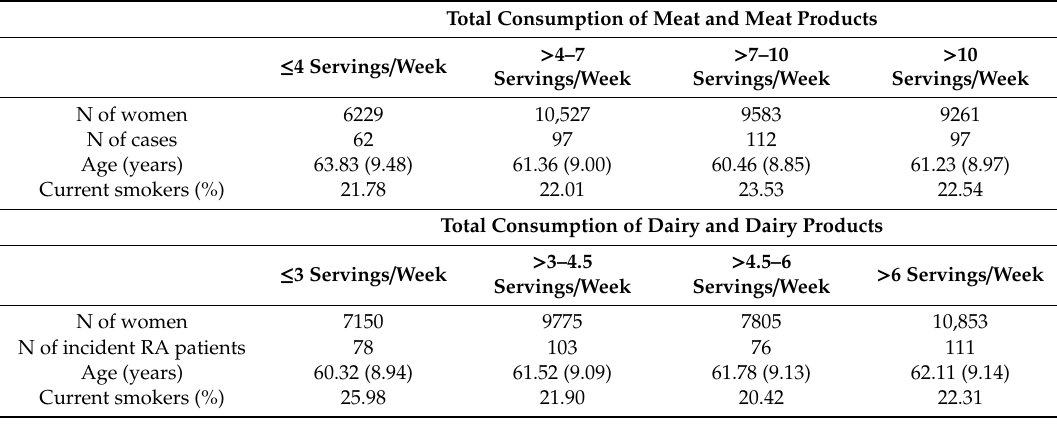
Table 1. Characteristics of 35,600 women born in 1914–1948 from the Swedish Mammography Cohort in 1997.